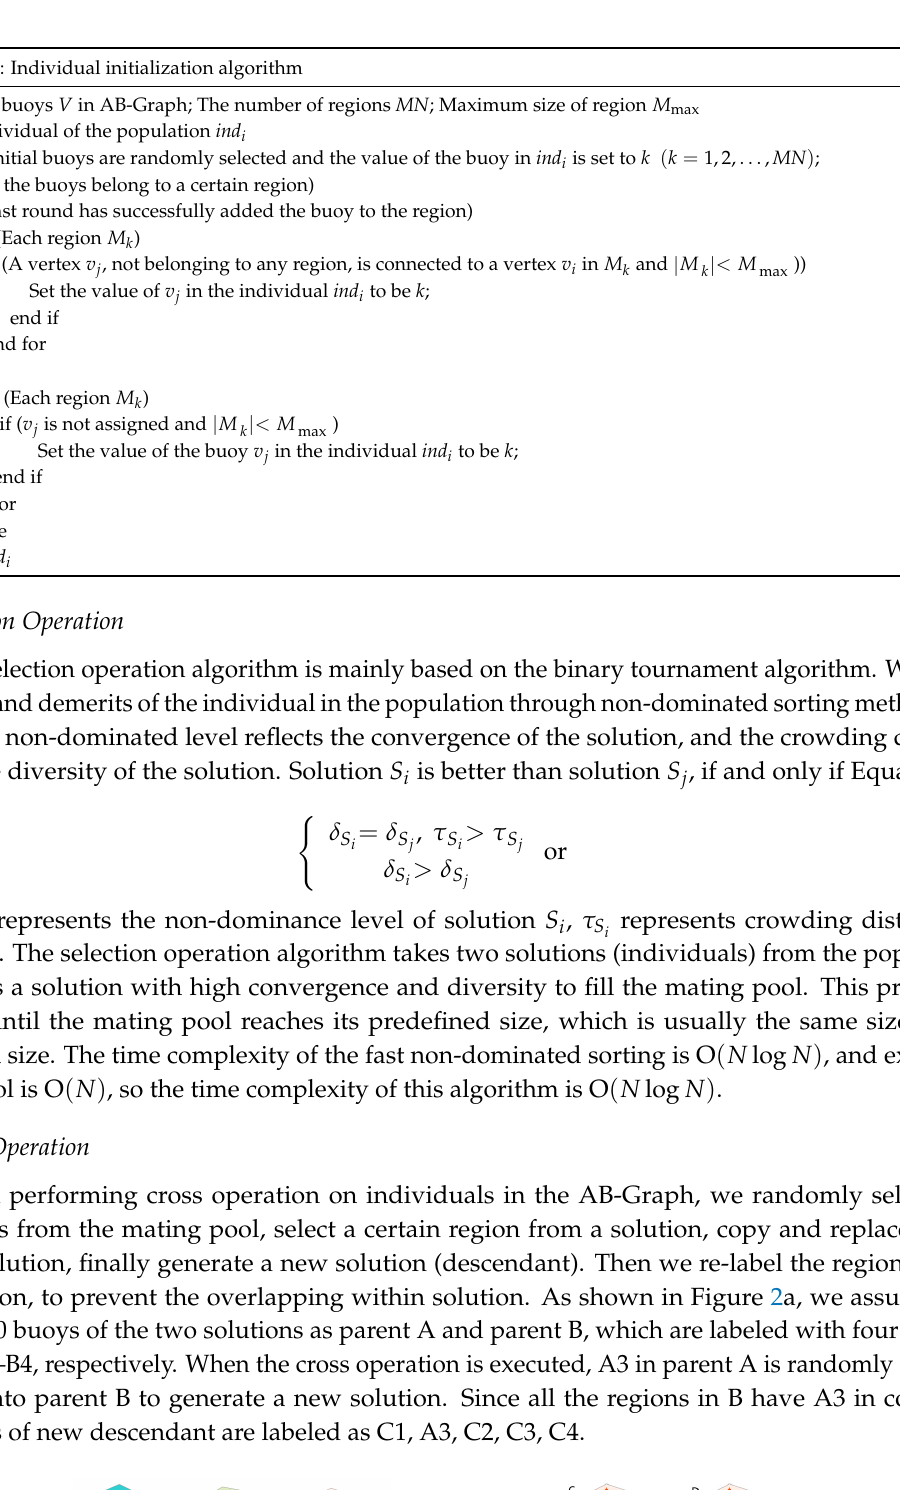
Algorithm 1 : Individual initialization